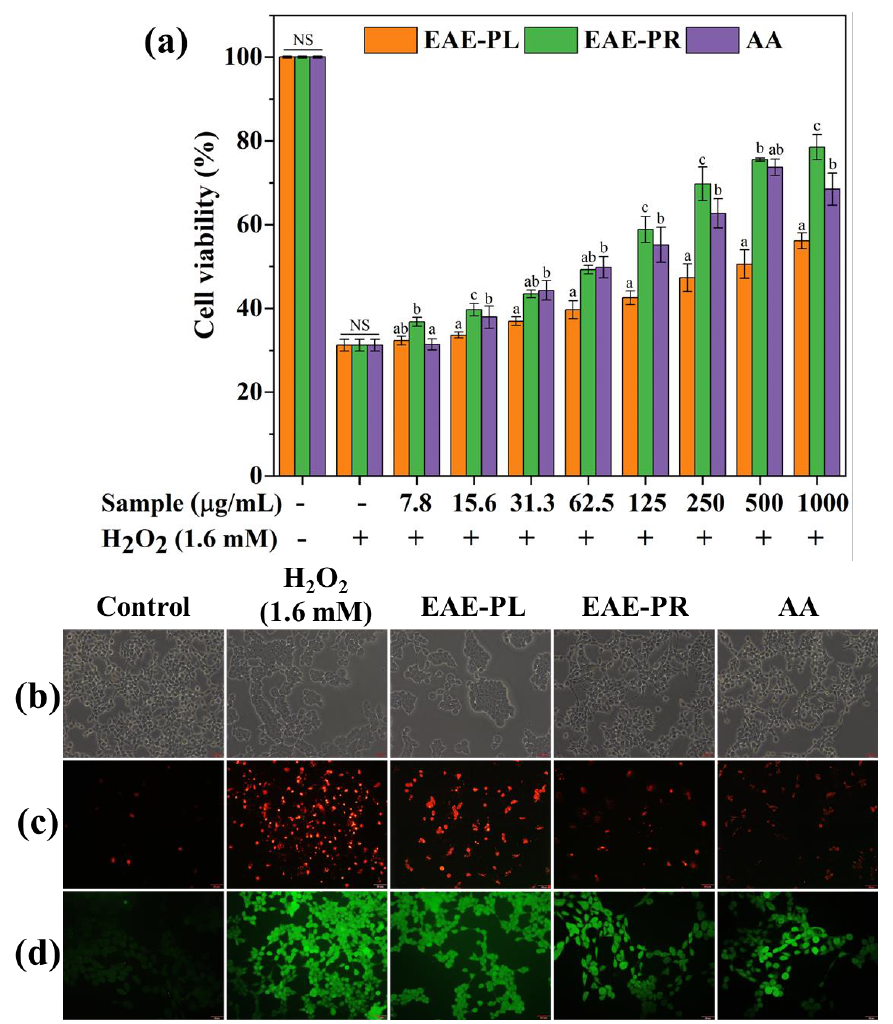
Figure 3. Analysis of the cytoprotective effect of the EAE-PL and EAE-PR in HEK-293 cells against H 2 O 2 stress using an MTT assay ( a ), light microscopy ( b ), and a florescent staining assay ( c , d ), where the light microscopy ( b ), PI ( c ), and DCFH-DA ( d ) staining examinations were performed with a 50 µ m scale bar. Error bars represent the SD of 3 independent experiments and superscripts on error bars represent significance ( p < 0.05) among the